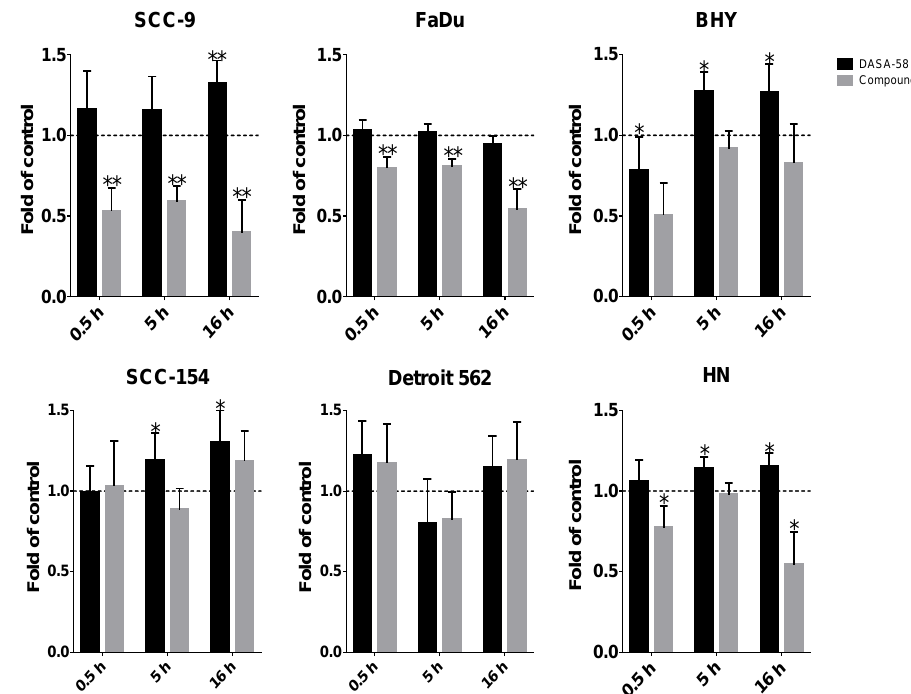
Figure 5. DASA-58 and Compound 3k can affect compensatory glycolysis. Compensatory glycolysis (corresponds to the GlycoPER value of measurement 6 in the kinetic graphs as shown in Figures 4b, S2 and S4, and measurement 11 for 0.5 h stimulation in Figure S3) after 0.5, 5 h and 16 h of treatment with 30 µM Compound 3k or DASA-58 in all six investigated HNSCC cell lines. Shown are changes in relation to the vehicle-treated control. Data points represent means with SD, n = 10. *: p < 0.01, **: p < 0.001, one sample t -test.